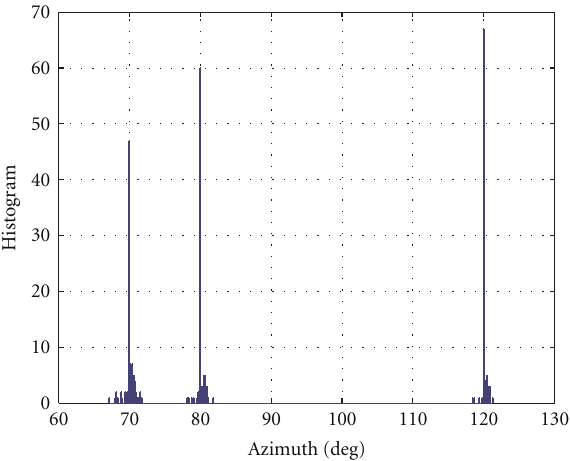
Figure 10: Histogram plot of estimated azimuth angles using ESPRIT algorithm after applying proposed compensation.